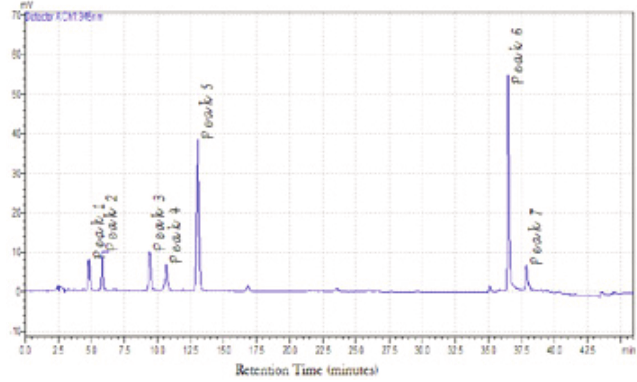
FIGURE 1 - HPLC chromatogram of the yarrow extract.